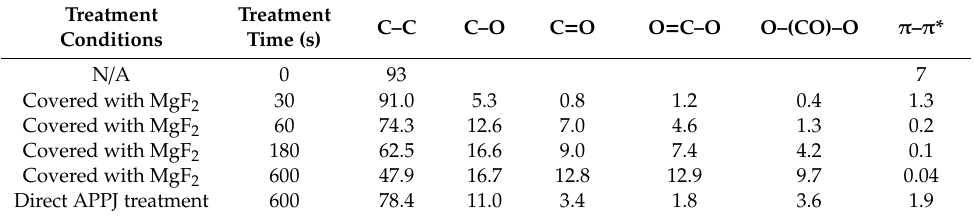
Figure 8. XPS C1s spectrum with subcomponents for PS treated for 10 min by: ( a ) VUV radiation and ( b ) by direct plasma jet. Table 3. XPS evolution of functional groups of PS treated by VUV radiation versus treatment times. For comparison, direct plasma treatment of PS for the longest treatment time is also shown.